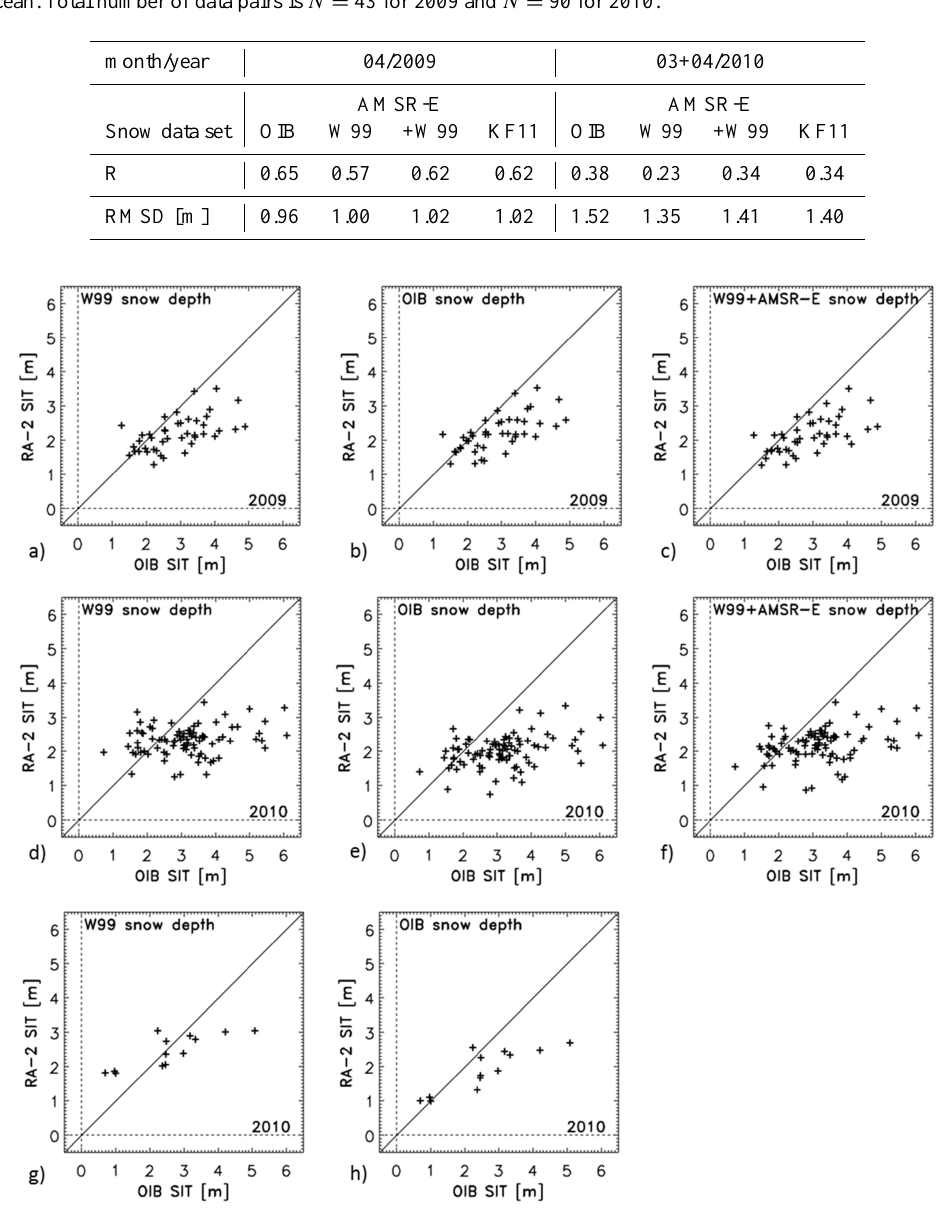
Figure 8. RA-2 sea ice thickness computed using different snow depth data sets versus OIB sea ice thickness for 2009 ( a to c ) and 2010 ( d to h ). Images (a) to (f) are for the Arctic Ocean, images (g) and (h) are for the Fram Strait